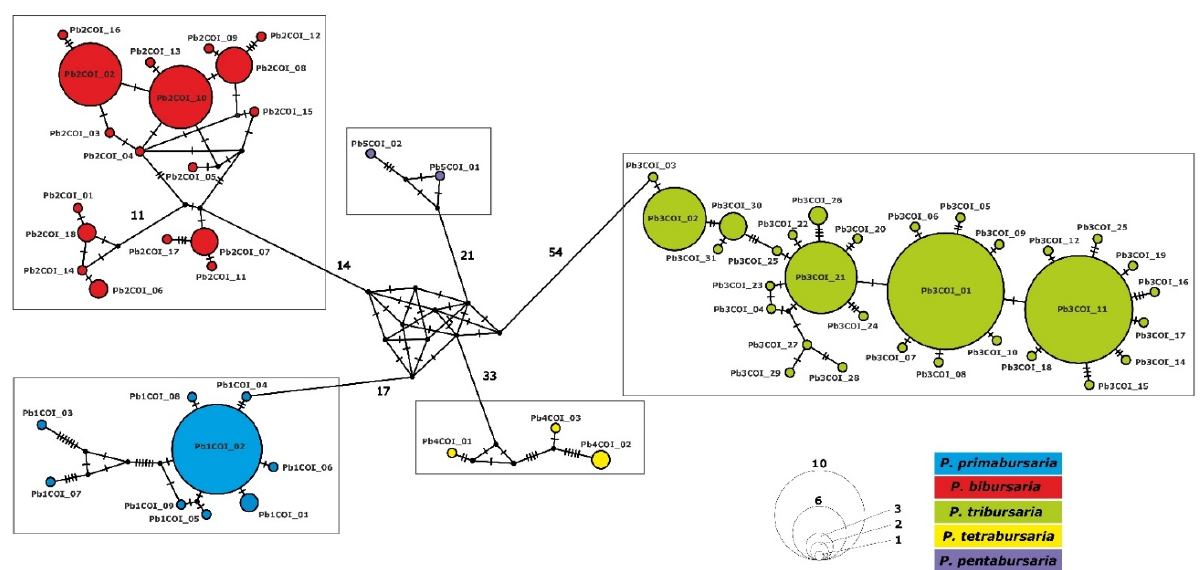
Figure 3. Haplotype network of the Paramecium bursaria complex constructed using 132 mitochondrial COI gene sequences. The network presents interrelationships among P. bursaria strains. Hatch marks on individual branches represent nucleotide substitutions (the corresponding number is provided for more than 10 substitutions). Analyses are conducted using the median joining method in PopART software v. 1.7.